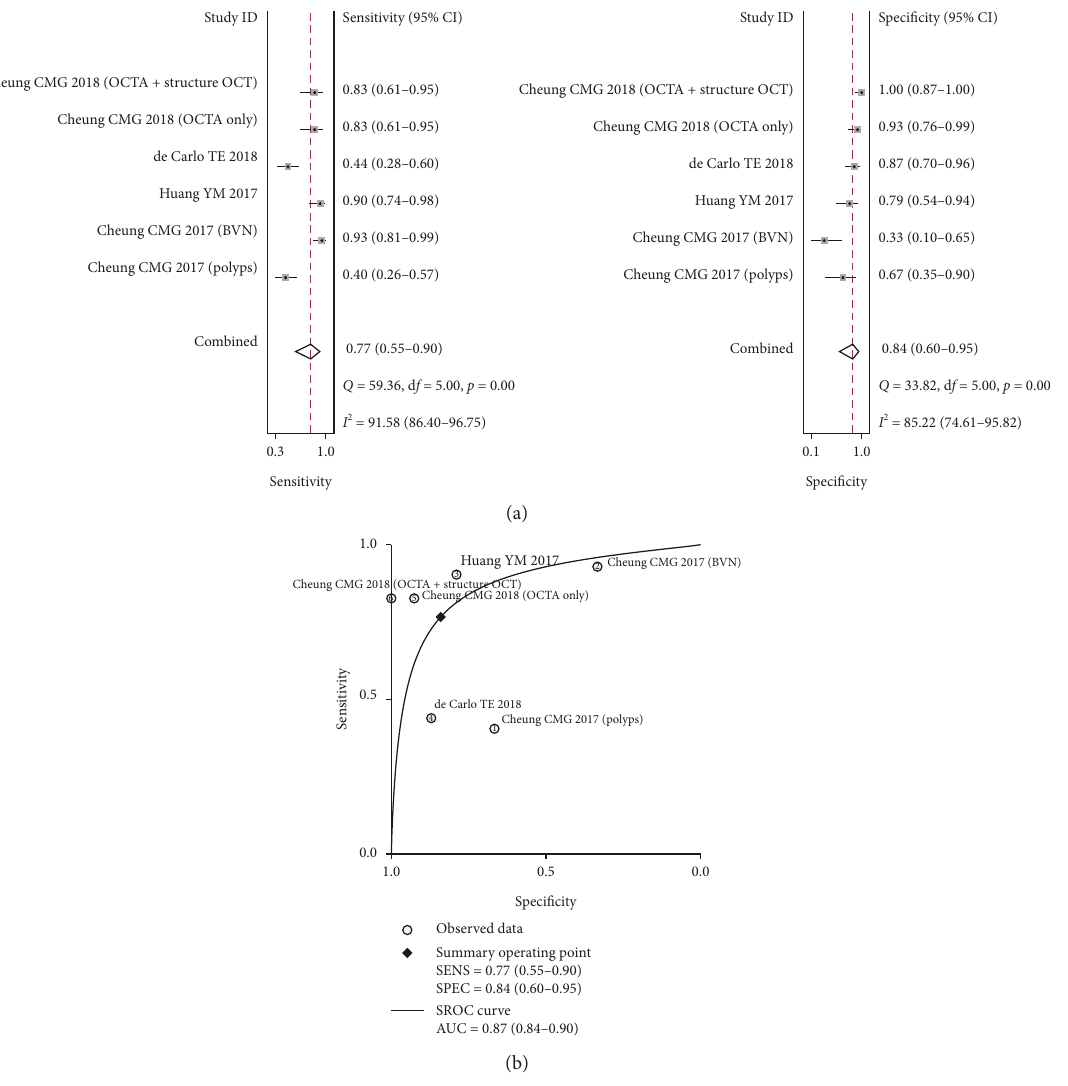
Figure 3: Forest plot and SROC curve showing the diagnostic value of OCTA in PCV diagnosis. Forest plot showing the combined sensitivity and specificity of OCTA in the diagnosis of PCV (a) and the SROC curve of OCTA in the diagnosis of PCV